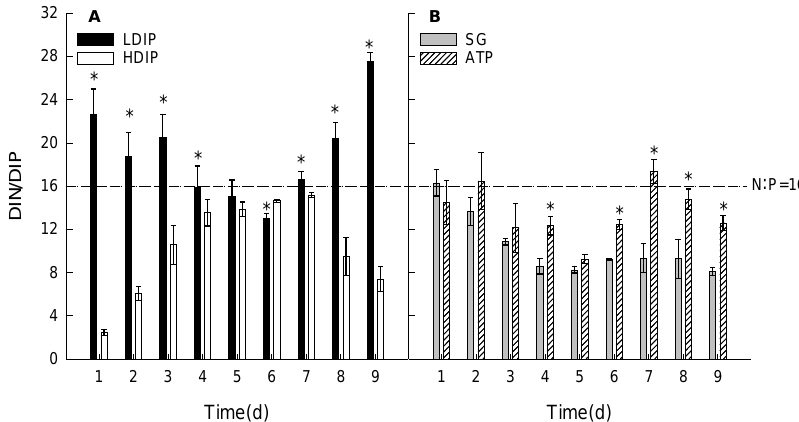
Figure 8. Changes in the N/P ratio in the water of C. roscoffensis culture groups of inorganic ( A ) and organic ( B ) initial phosphorus resources. (LDIP): low concentration of inorganic phosphorus; (HDIP): high concentration of inorganic phosphorus; (SG): Na 2 -glycerophosphate; (ATP): adenosine triphosphate. * statistical significance, p < 0.05.